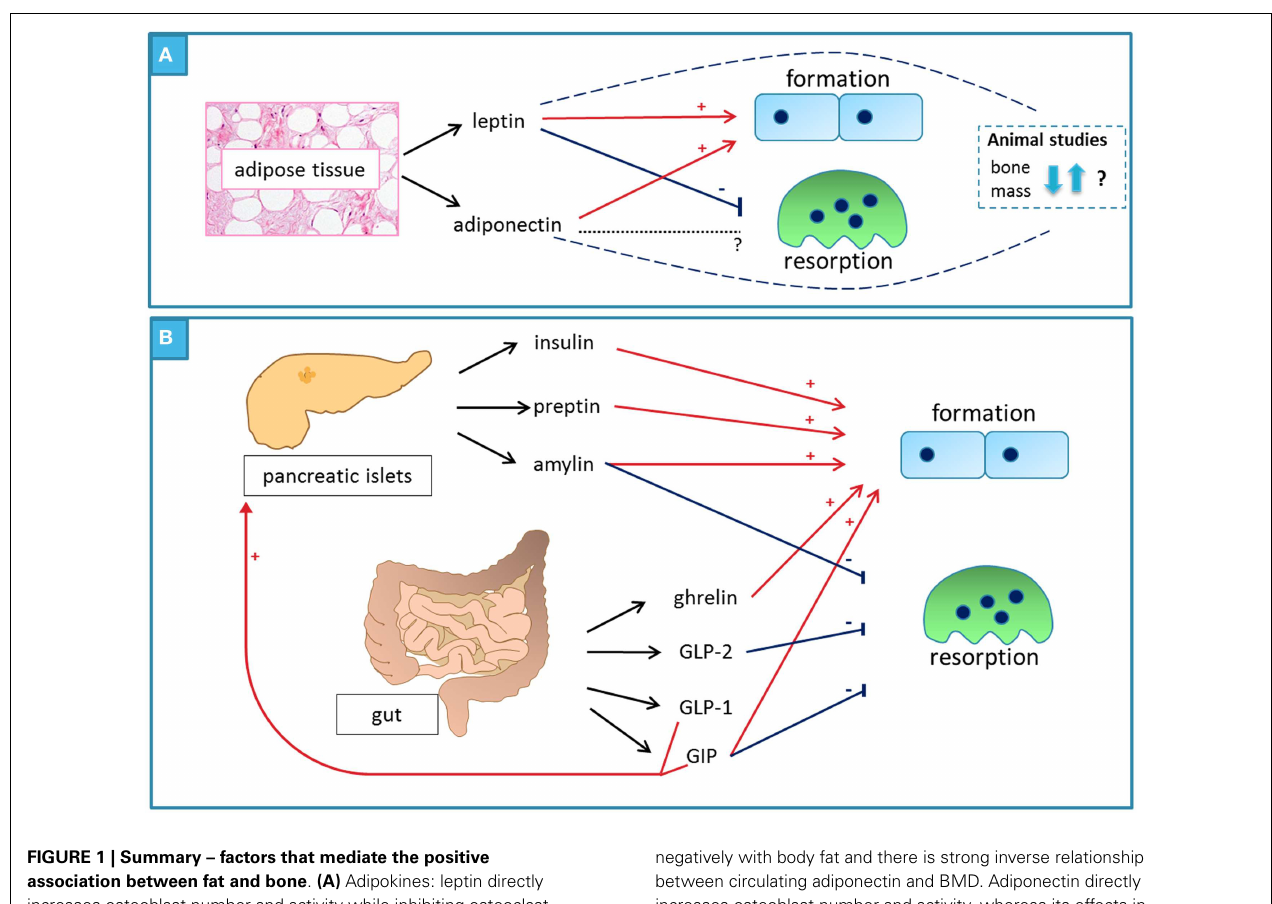
FIGURE 1 | Summary – factors that mediate the positive association between fat and bone . (A) Adipokines: leptin directly increases osteoblast number and activity while inhibiting osteoclast activity, producing an overall anabolic bone effect. Animal studies produced conflicting results, some suggesting anabolic effect on bones and others showing negative bone effects through indirect mechanisms. Adiponectin – circulating levels of adiponectin correlate